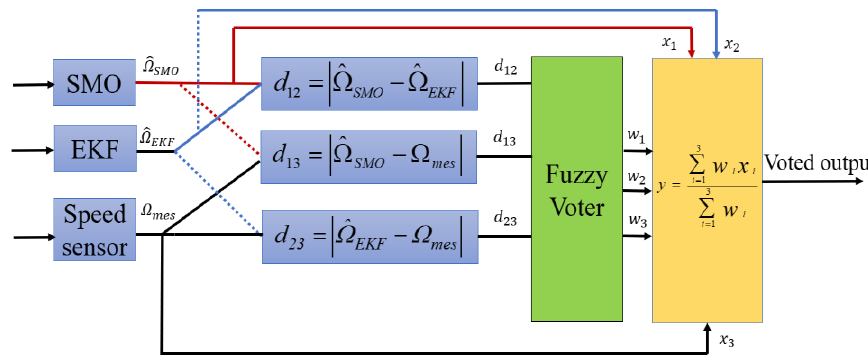
Figure 12. The structure of the fuzzy voter.